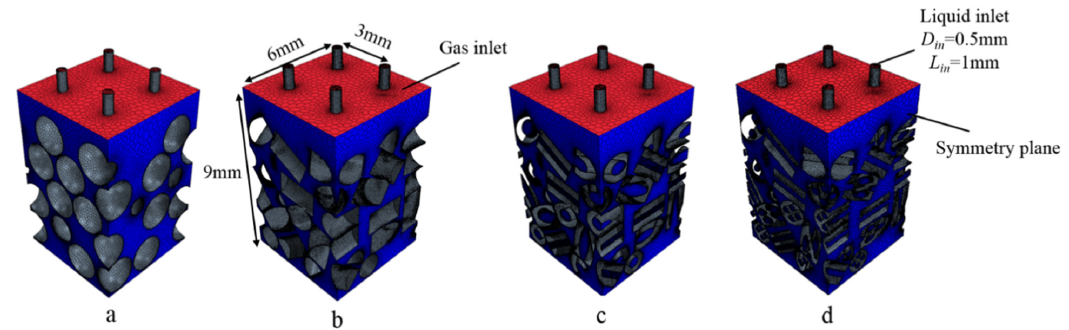
Table 2. Geometric size of four kinds of particles.